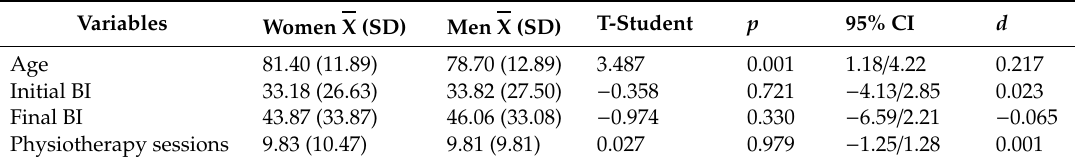
Table 3. Student’s t -test for independent samples